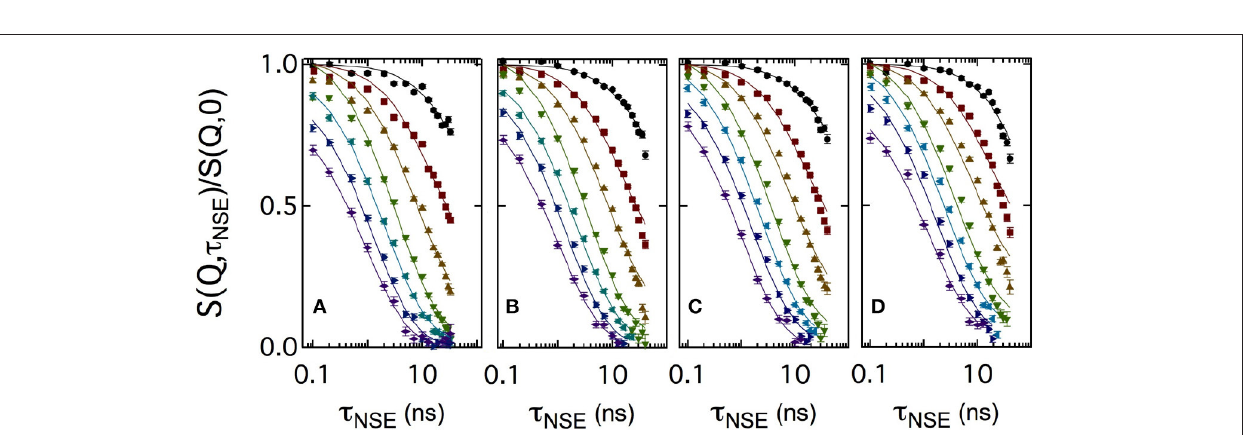
κ 0, Phase from the phase diagram, and κ 0, SANS from SANS as well as κ 0,SANS from SANS ¯ ¯ | NSE